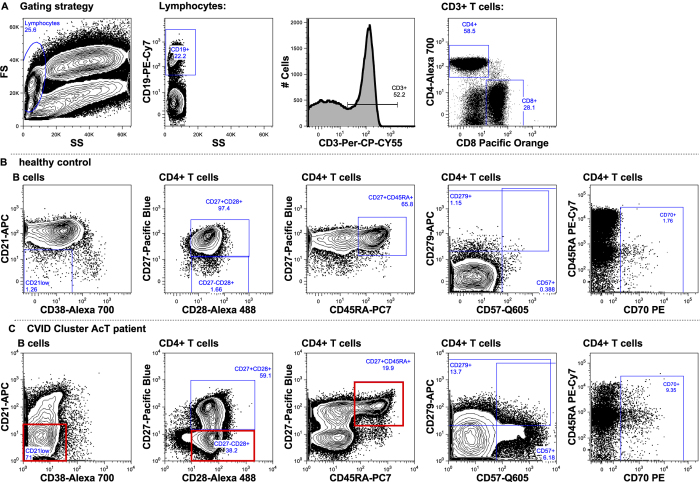
Typical immunophenotype of a CVID-AcT patient.Gating strategy for B and T-cell analysis (A), with relevant B and CD4+ T cell subsets displayed in healthy donor (B) and in CVID AcT patient (C), gates used for simplified definition are highlighted in red.